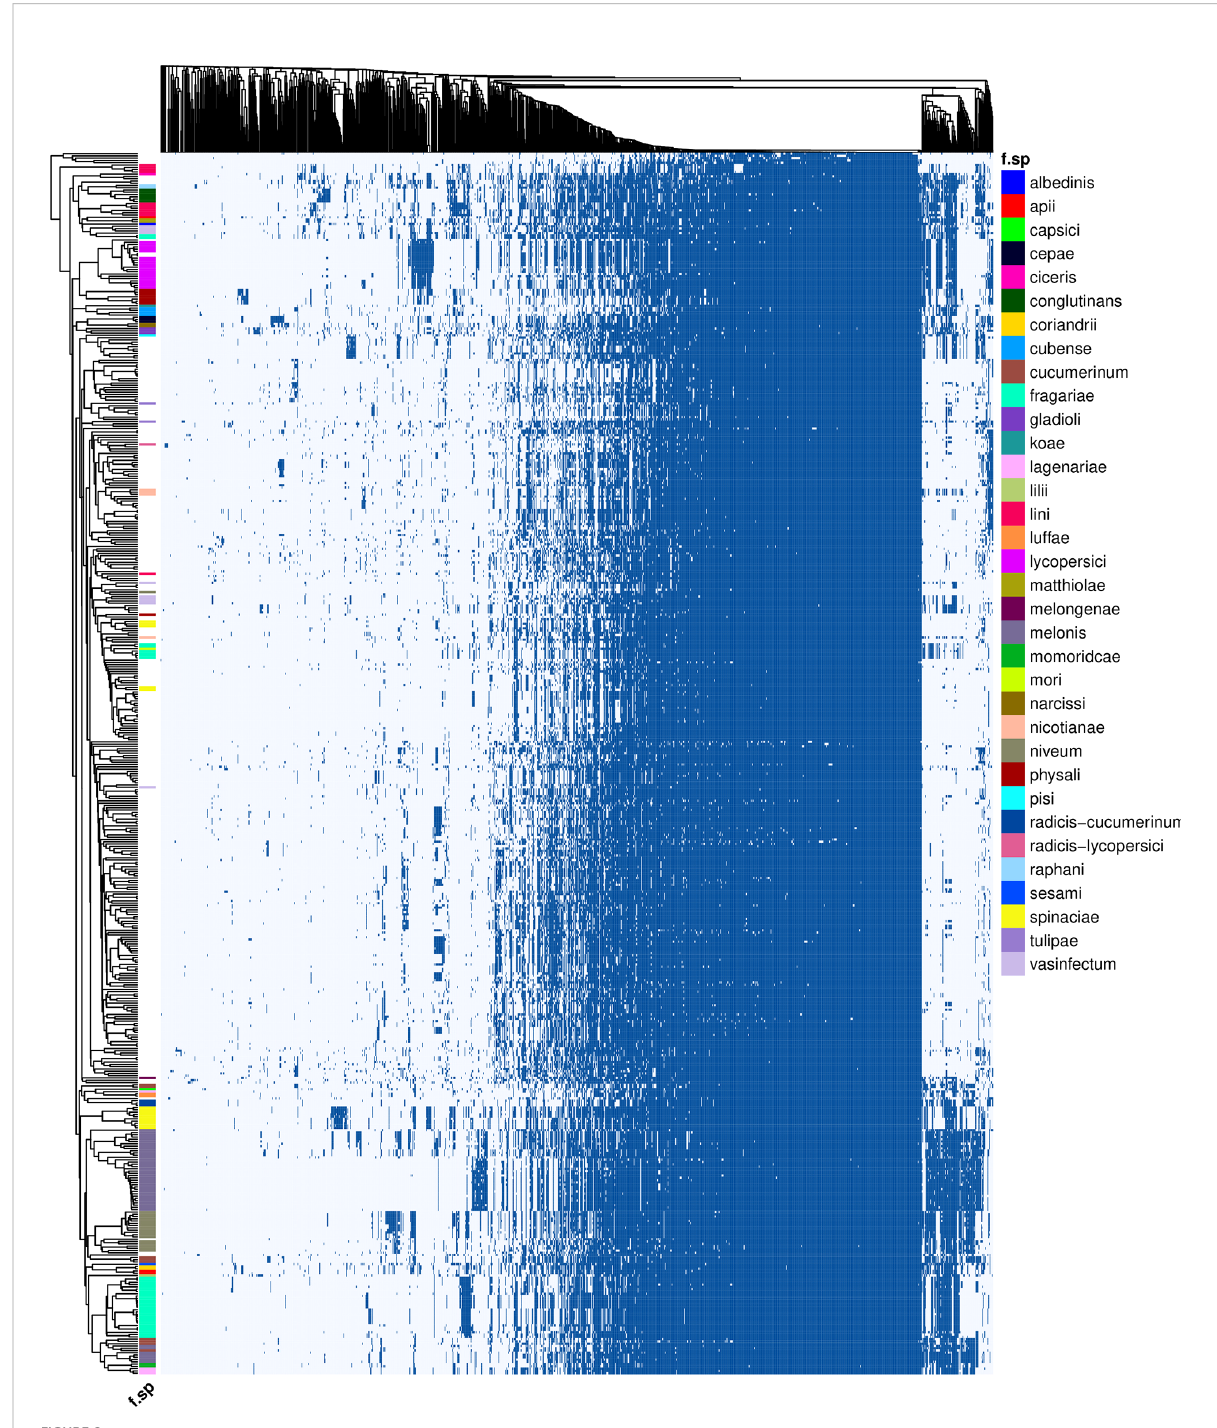
FIGURE 2 Presence (dark blue) / absence (light blue) variation of 1,283 putative effectors (columns) across 538 Fusarium genomes (rows). Genomes are annotated by forma specialis when possible. Presence is determined by nhmmer, given the thresholds E-value ≤ 10E-10, query coverage ≥ 80%. Clusters were generated with a binary distance matrix and average